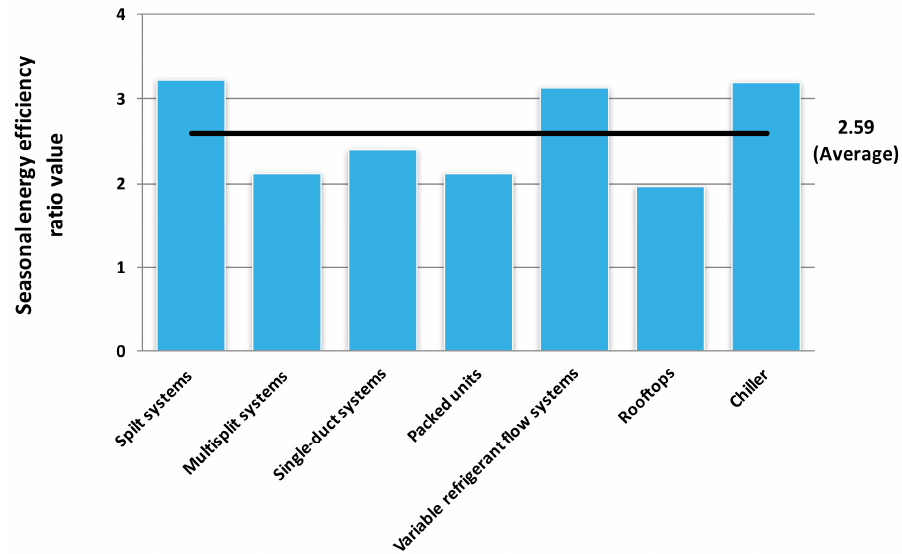
Figure 12. Seasonal energy efficiency ratio ( SEER ) per AC type, EU15 (see references in the Appendix